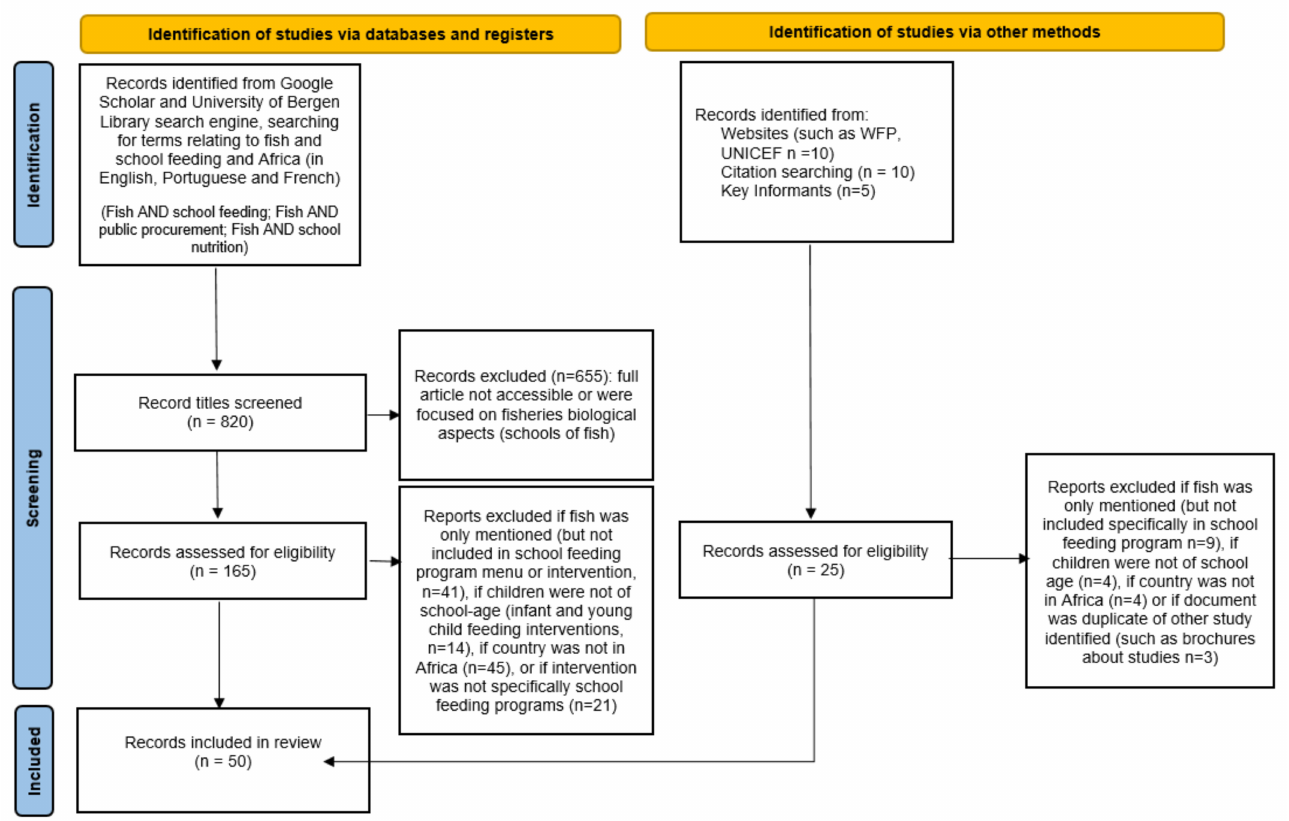
Figure 1. Search strategy and search